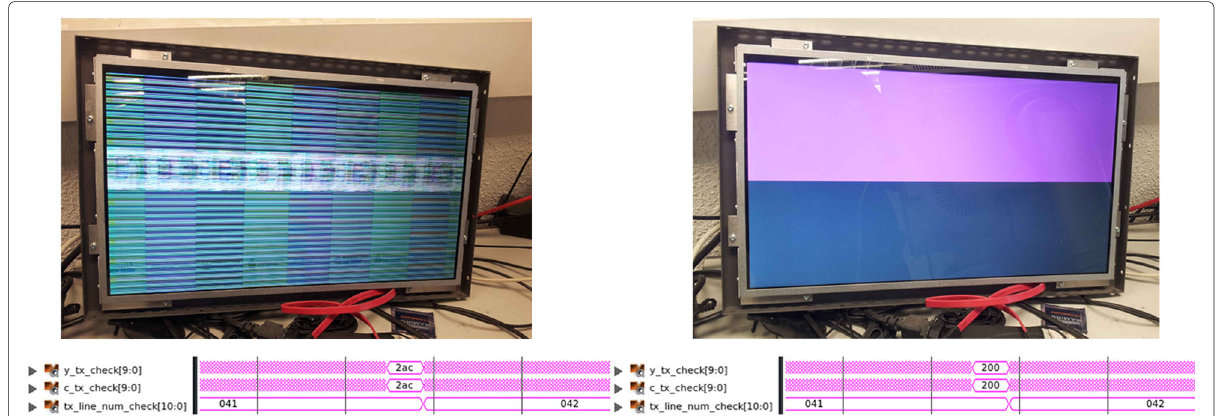
Fig. 13 The test-bench is applied to solve a real case: a vertical synchronization